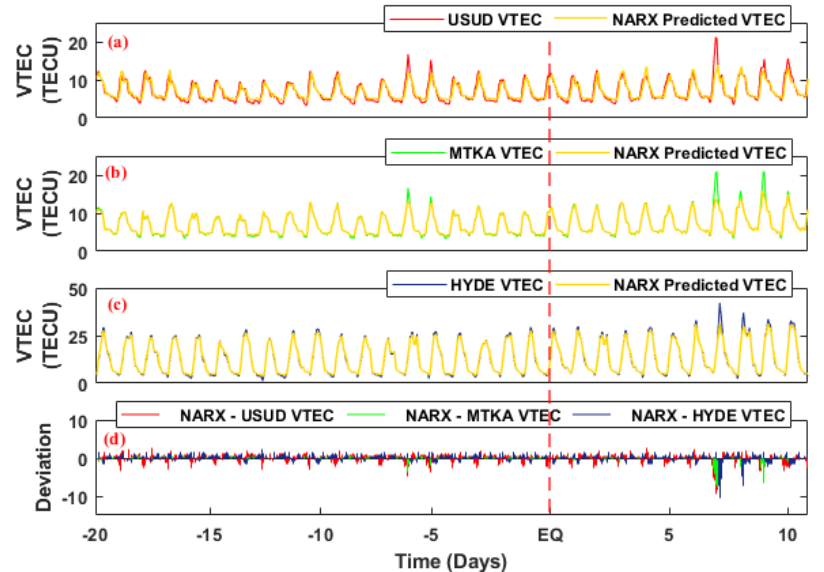
Figure 11. ( a ) Variation of USUD VTEC with NARX-predicted VTEC, ( b ) Time series variation of MTKA VTEC with NARX-predicted VTEC, ( c ) Variation of HYDE VTEC with NARX-predicted VTEC, ( d ) Deviation of NARX-predicted VTEC from USUD, MTKA, and HYDE VTEC. The red dashed line shows the earthquake day.